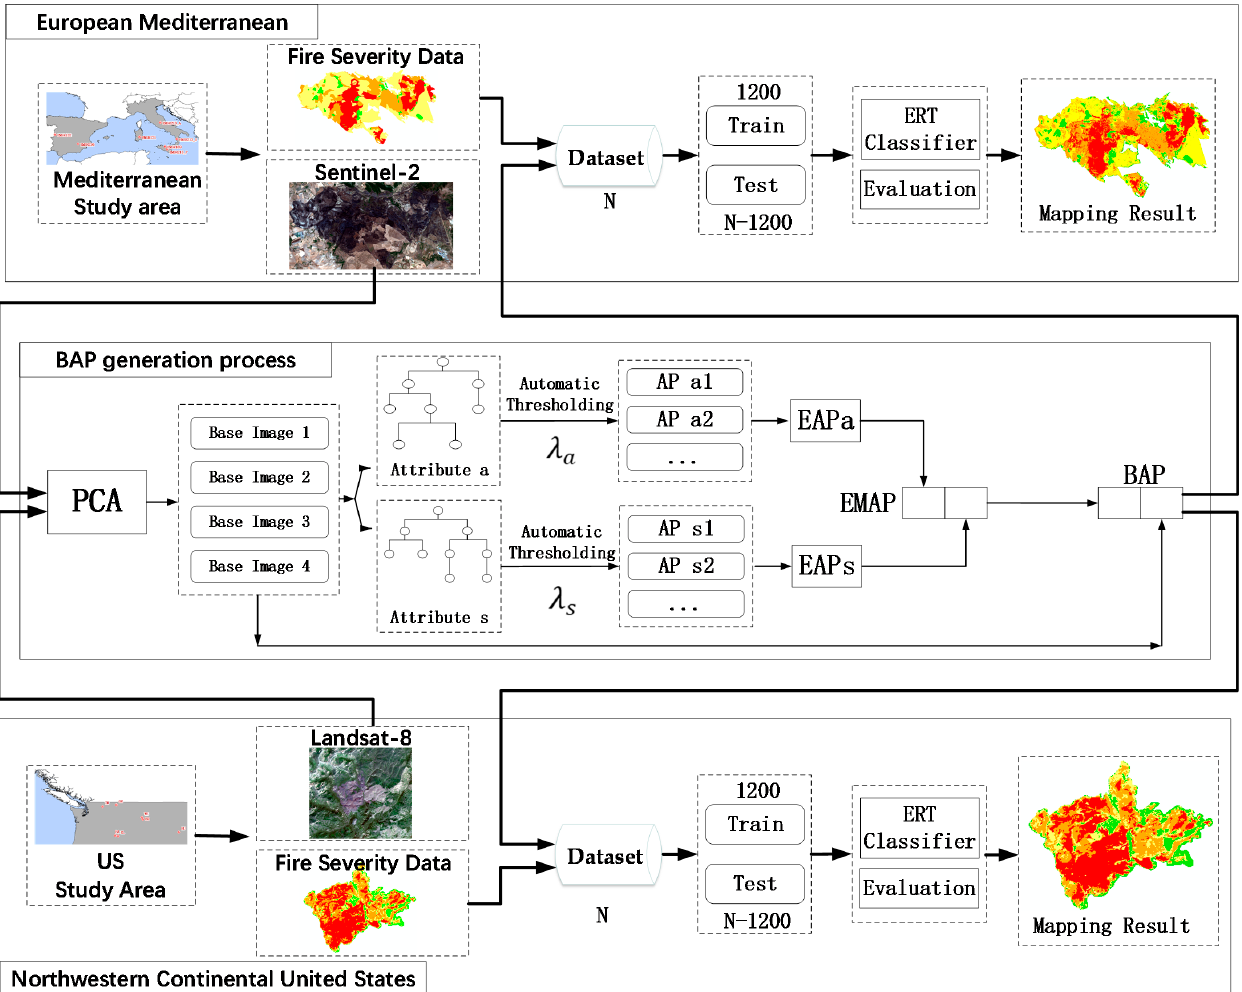
Figure 3. Proposed fire severity mapping